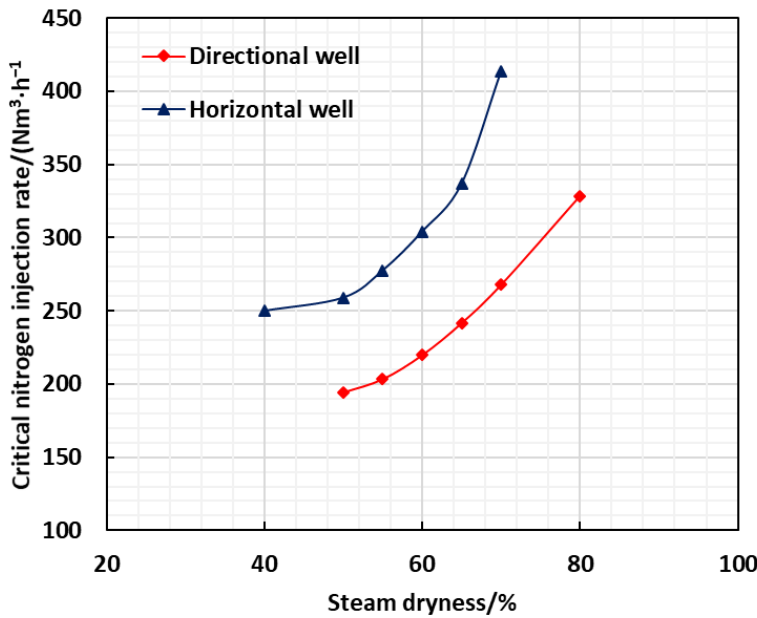
Figure 4. Relationship between steam quality and critical nitrogen injection displacement.